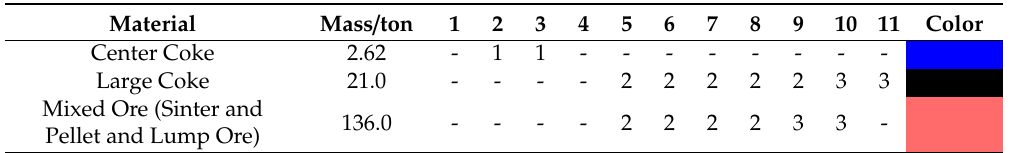
Table 1. Charging matrix of the illustration case. The charging direction (here wall → center) and charging level (here, z = − 1.4 m) have to be specified. The final column refers to the layer colors in Figure